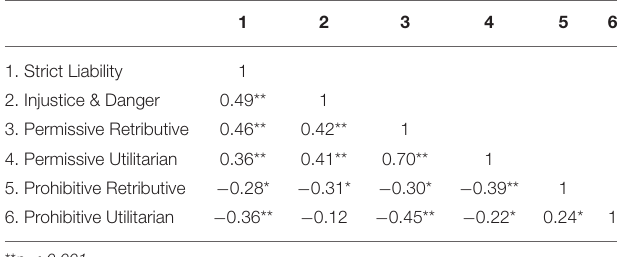
TABLE 1 | Bivariate relationships among attitudinal measures.